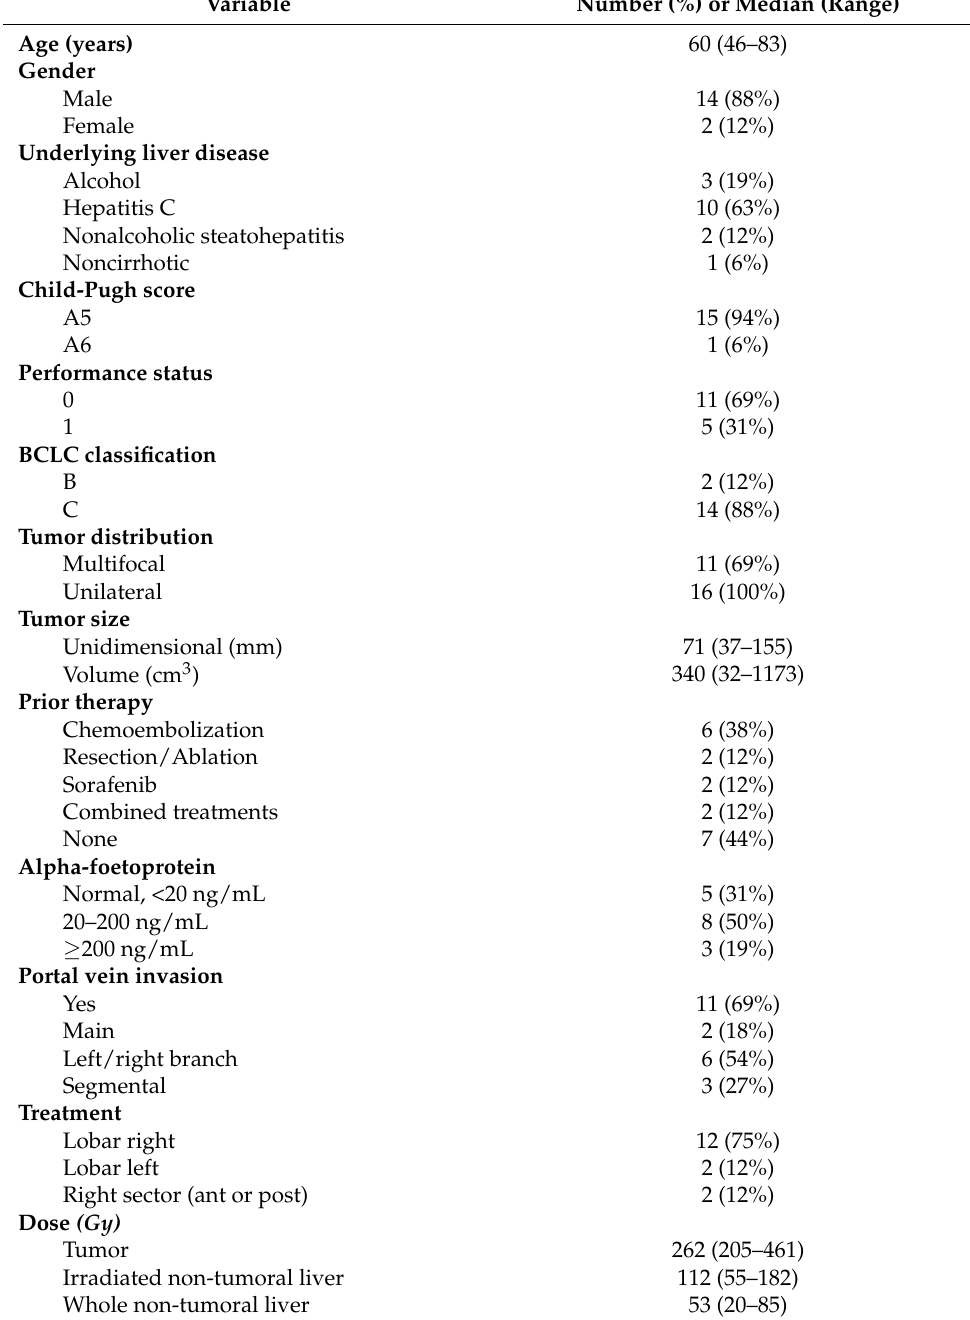
Table 1. Characteristics of patients, tumors, and